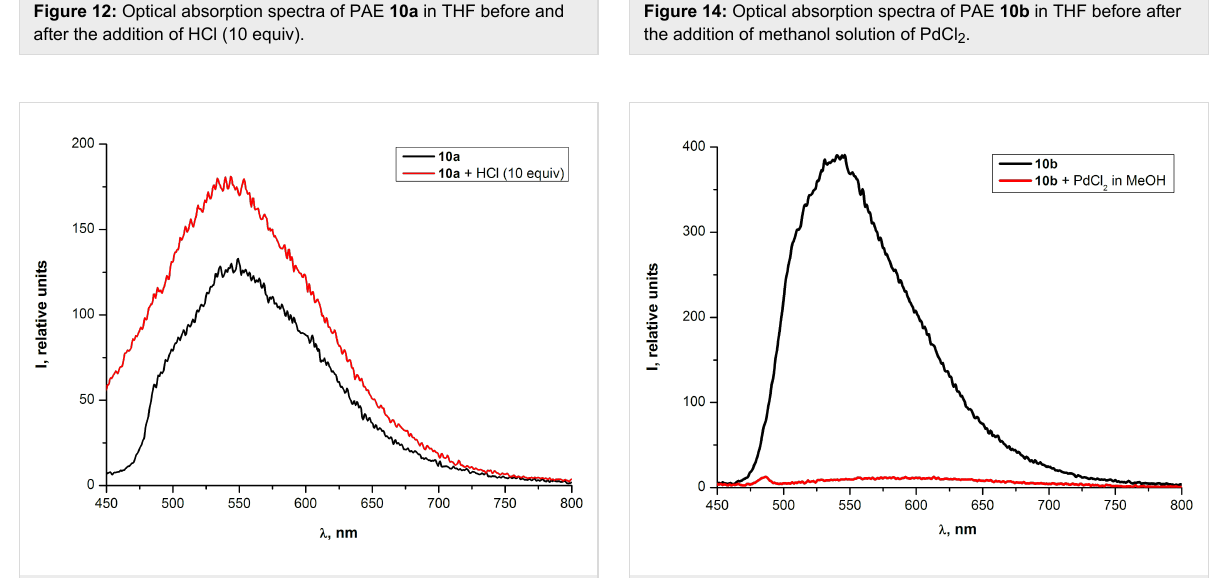
Figure 15: Emission spectra of PAE 10b in THF before and after the addition of methanol solution of PdCl 2 .